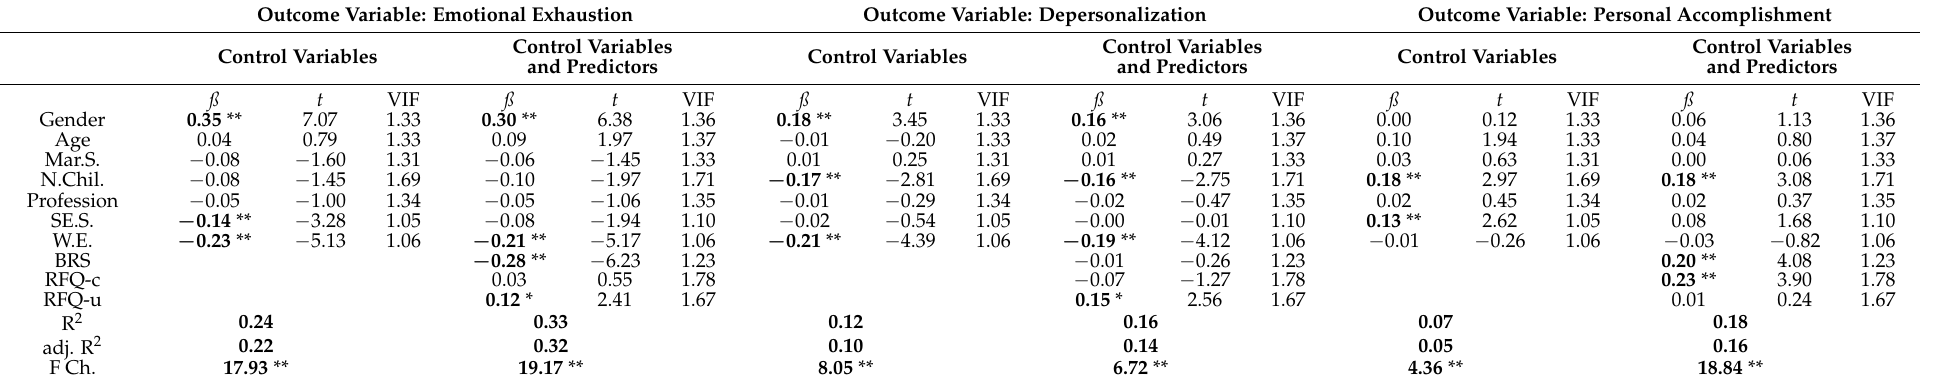
Table 3. Hierarchical linear regression analysis of the relationship among burnout dimensions, resilience, and mentalizing. Outcome Variable: Emotional